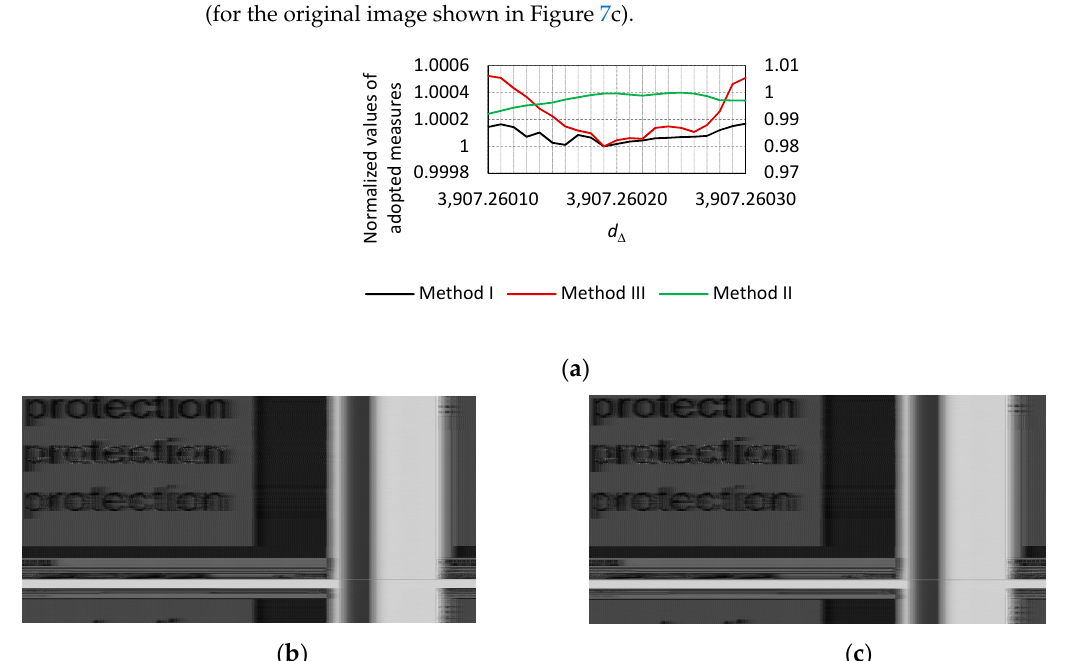
Figure 23. ( a ) The normalized values of the adopted measures (method I, II and III) calculated in domain of image line length d ∆ for the accuracy ∆ = 0.00001 (for the original image shown in Figure 7c) and images reconstructed on the basis of the recorded revealing emission signals at frequency f o = 768 MHz (receiving bandwidth BW = 50 MHz, accuracy ∆ = 0.00001), ( b ) for estimated line length d ∆ = 3907.26019 and ( c ) for estimated line length d ∆ = 3907.26025 —multiple of image summation Sum MTL = 60, the source of revealing signal emission—display monitor, HDMI standard.